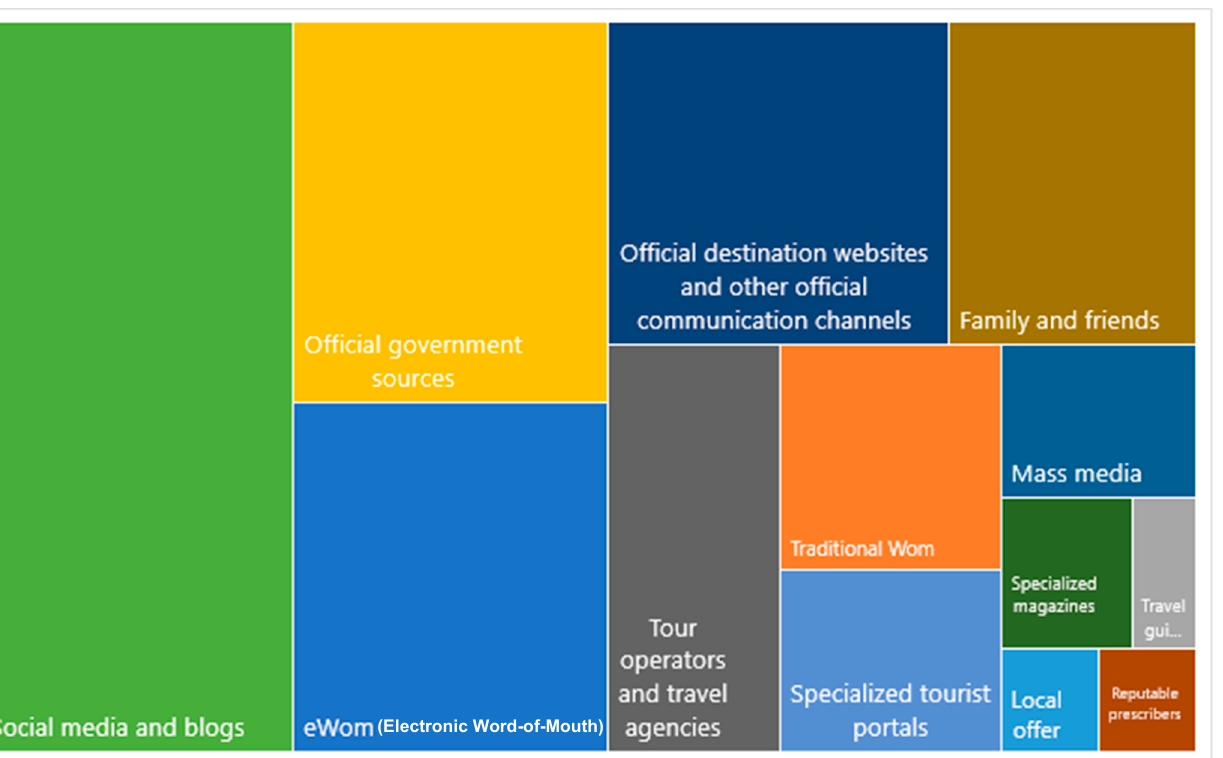
Figure 1. Sources of information for making tourism decisions after the pandemic.